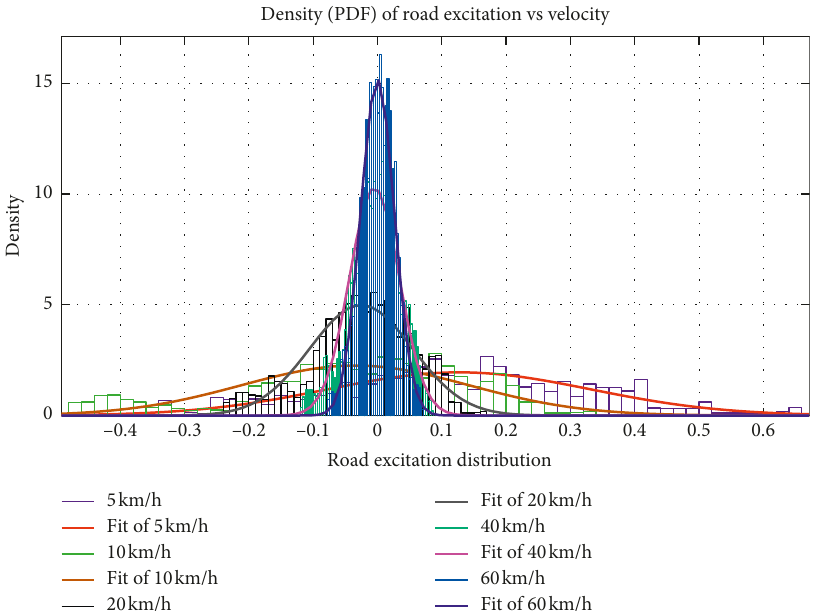
Figure 11: The distribution characteristics DPF of z Table 1: The variation of the road distribution parameters z